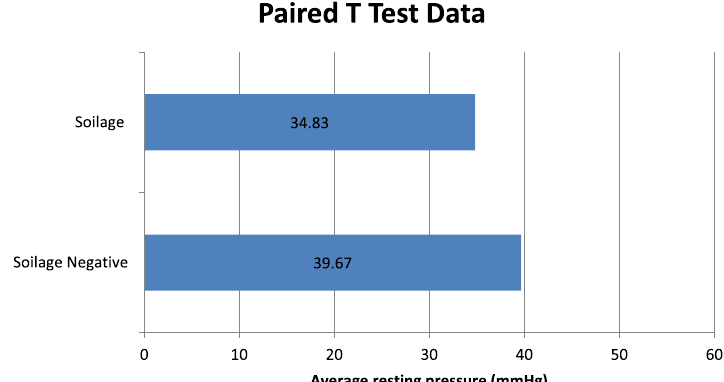
Fig. 2 Average resting pressure in patients with soilage and without